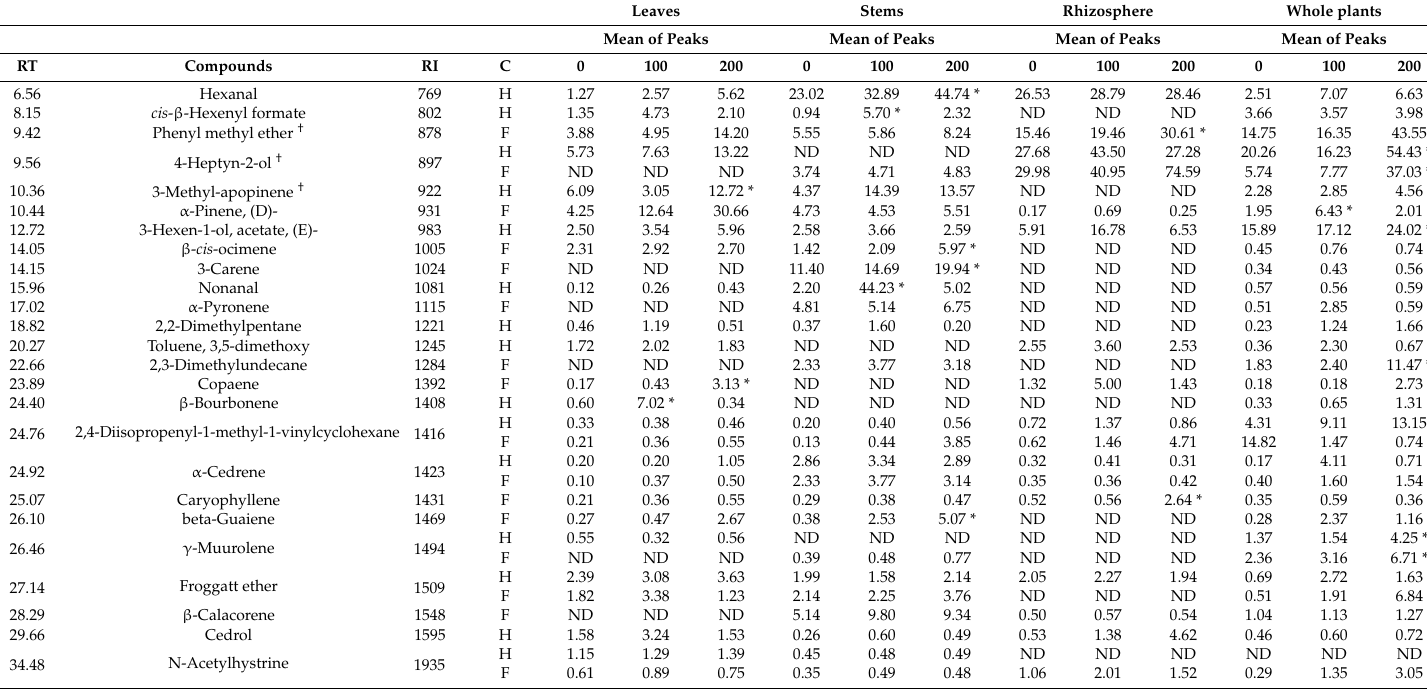
(*) Means: there are significant differences between different concentrations of BA (0(control), 100, 200 mg/L) with LSD p ≤ 0.05; (RT) retention time, (RI) retention index based on alkane series, (C) means cultivars of Roses (F) Floribunda and (H) Hybrid Tea, (ND) not detected. (†) Means: components that increased significantly in leaves, stems, rhizosphere and whole plants with increasing level of BA as compare to